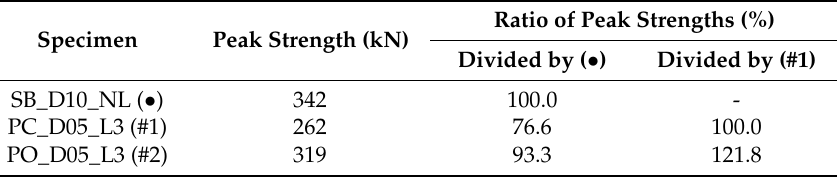
Table 5. Effect of steel pile cap strengthening methods for D10_L3 specimens.